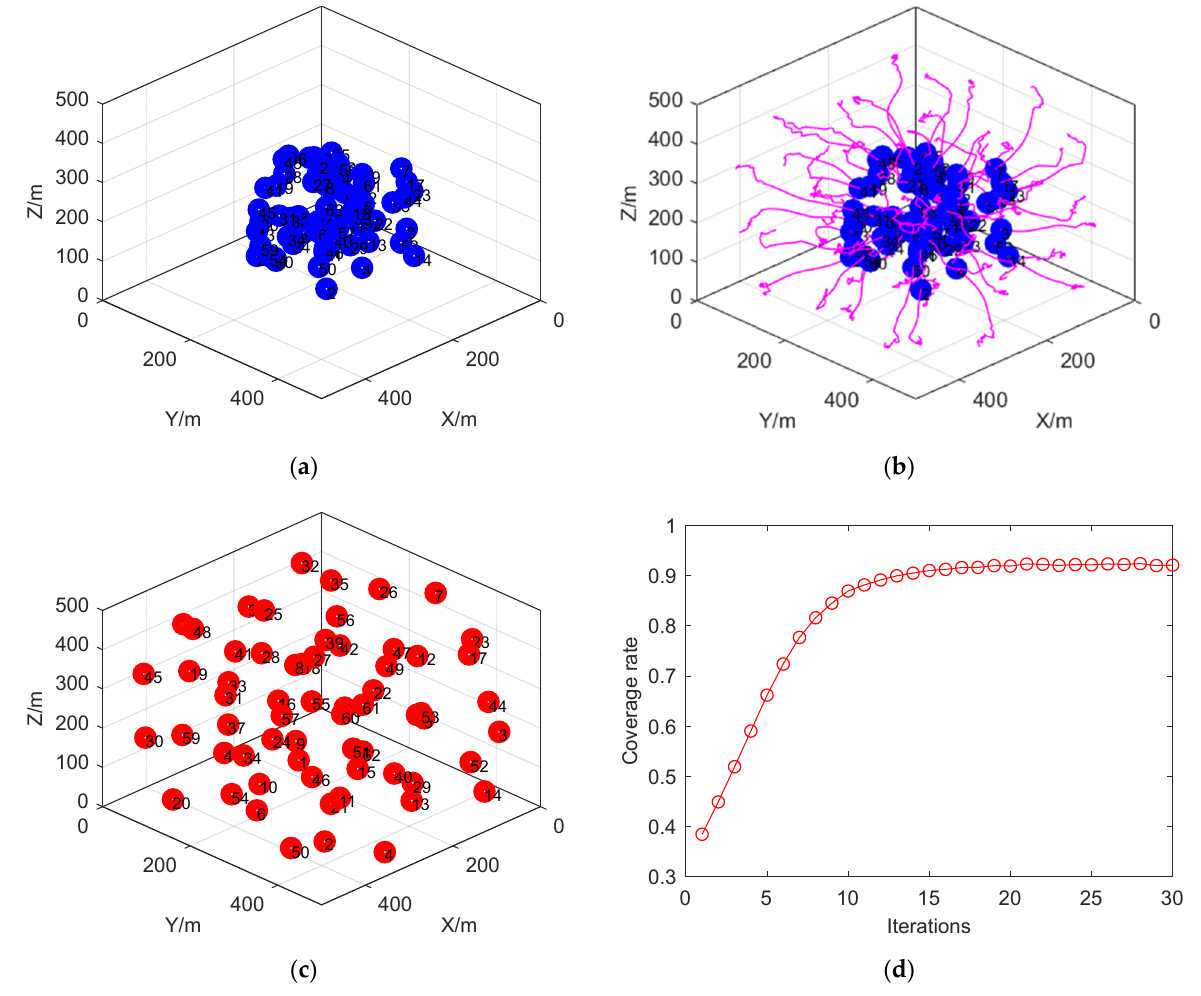
Figure 8. 3D space node movement process via centered. ( a ) Node initial deployment. ( b ) Node movement track. ( c ) Optimized node deployment. ( d ) Coverage curve.